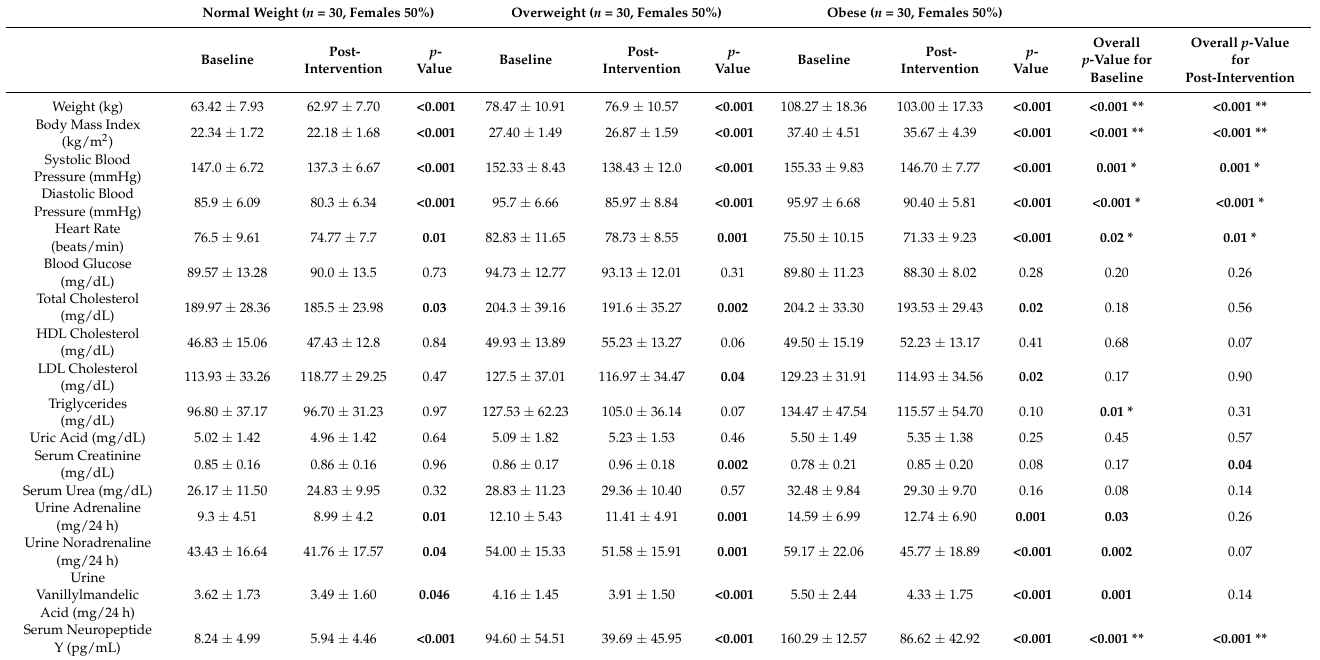
Table 1. Descriptive characteristics of study participants and effect of the 12-week